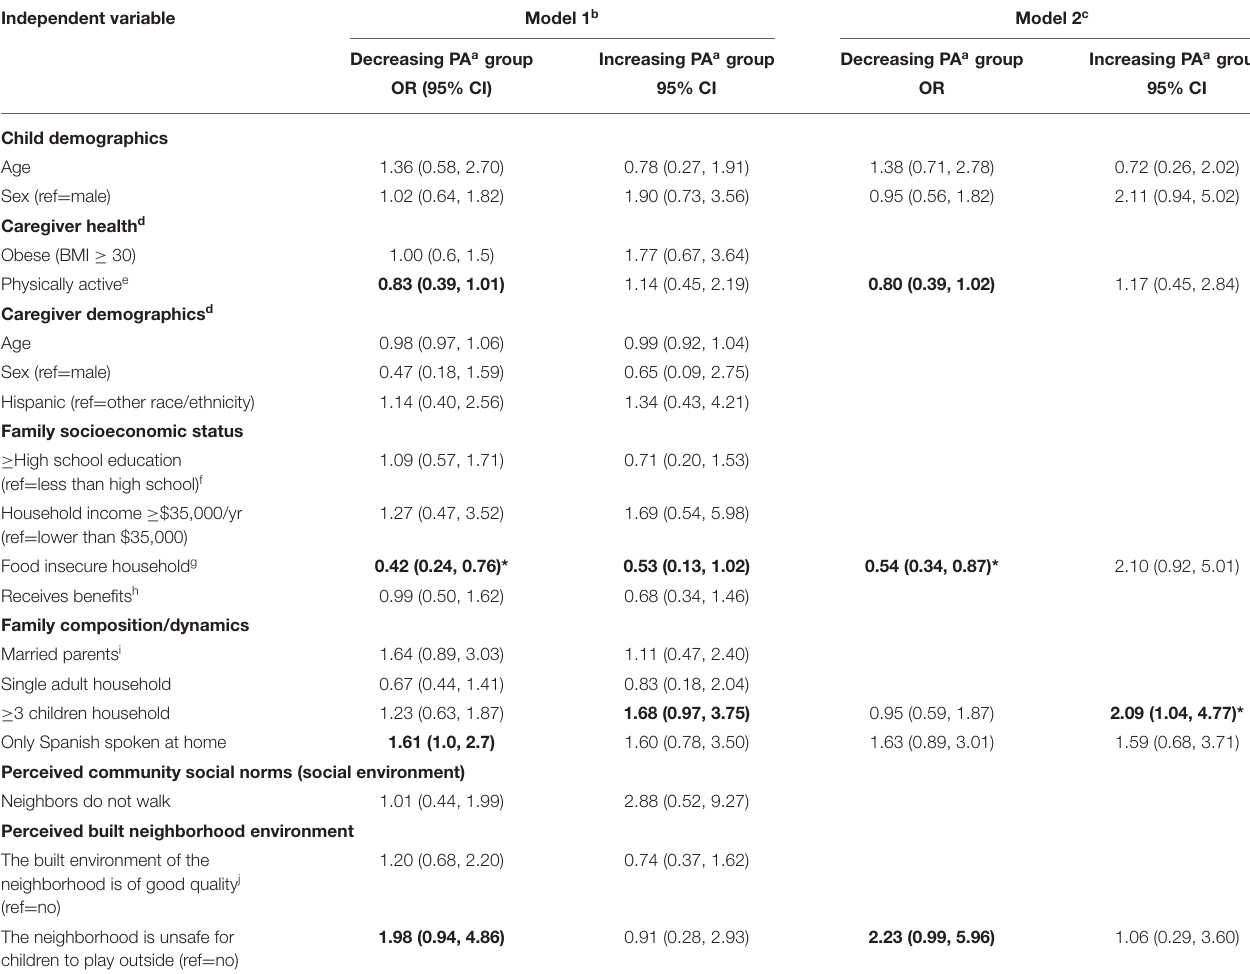
TABLE 5 | Associations between baseline ecological characteristics and child weekly physical activity frequency (PA a ) change status from baseline to follow-up (referent is “no change” group); Go Austin! Vamos Austin! cohort (2013–2017; n =